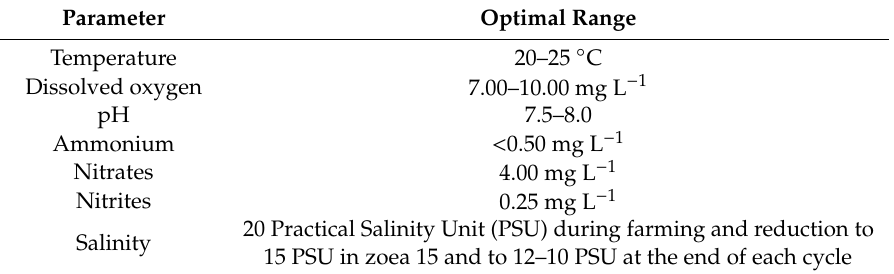
Table 4. Physical and chemical water properties for shrimp farming